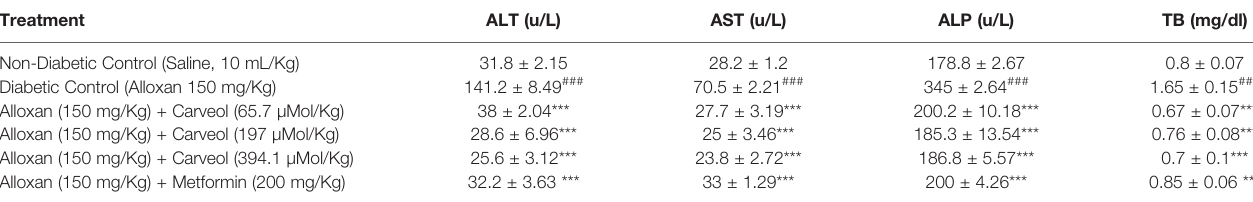
TABLE 6 | Effect of Carveol on levels of alanine transaminase (ALT), aspartate aminotransferase (AST), alkaline phosphatase (ALP), and total bilirubin (TB) in alloxan- induced diabetic rats. Treatment Non-Diabetic Control (Saline, 10